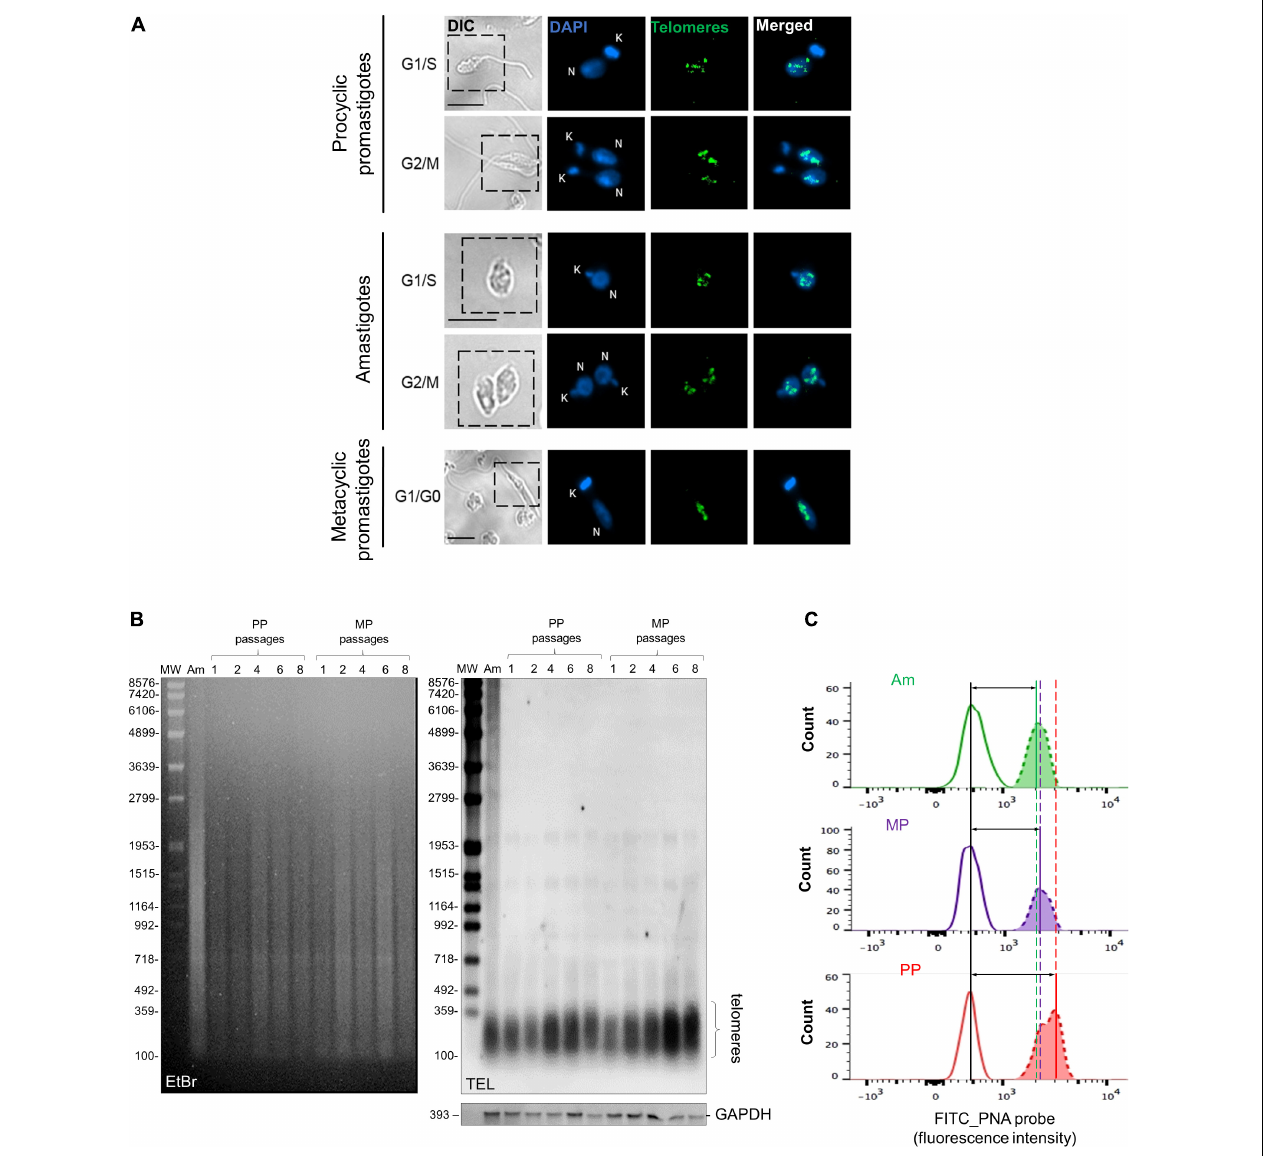
FIGURE 1 | L. amazonensis telomeres distribution and size during development and continuous passages. (A) Distribution of L. amazonensis telomeres in three parasites developmental stage obtained using telomeric FISH. Telomeres were hybridized with a FITC-labeled telomeric oligoprobe (CCCTAA) 3 (PANAGENE). DNA in the nucleus and kinetoplast were stained with Vectashield R (cid:13) mounting medium DAPI (Vector Labs). The images were analyzed using a Nikon 80i fluorescence microscope and were superimposed using NIS elements software (v. Ar 3.10). Bar 2 µ m. Telomeres are shown to form indistinct clusters and individual foci independent of the cell cycle phase and parasite life stages. (B) gDNA (1.0 µ g) of lesion-derived Am, PP (passages 1–8), and MP (passages 1–8) were digested with Afa I (10 U). DNA fragments were separated on 0.8% ethidium bromide (EtBr)-stained agarose gel. Southern blotting hybridization was done with a DIG-labeled telomeric probe (5 (cid:48) -TTAGGG 3 -3 (cid:48) ). As the loading control, a DIG-labeled probe that recognizes the L. amazonensis GAPDH gene was used. Chemiluminescent detection was performed using an anti-DIG specific antibody covalently coupled to alkaline phosphate (Roche) and CPD-Star (Roche). In addition, 1 kb plus DNA ladder and VII DIG-labeled were used as molecular weight markers (MW). (C) Flow-FISH analyses were performed with the three main parasite life forms using a PNA FITC-labeled (CCCTAA) 3 telomeric probe (PANAGENE). Histograms represent the average fluorescence intensity of non-hybridized parasites (at the left) and the telomeric probe (at the right). The data were analyzed using FlowJo software v.7.6.5. Vertical lines mark the difference between peaks, and horizontal lines with arrows, represent telomere length differences in the populations analyzed. The amount of fluorescence among samples was calculate using MESF ( Supplementary Table1